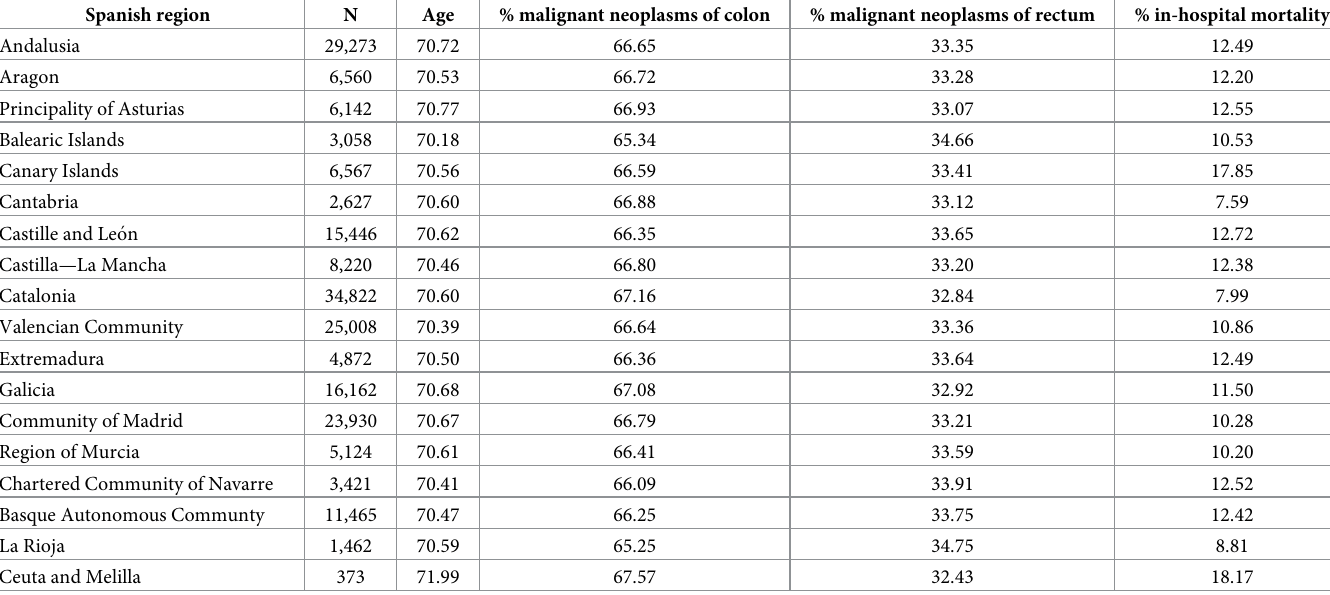
Table 3. Analysis of patient profile and in-hospital mortality per Spanish region.